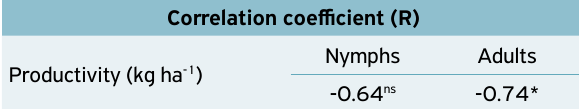
Table 2. Correlation coefficient (R) between root productivity (kg ha-1) and population of nymphs and adults of Vatiga illudens (Hemiptera: Tingidae), present in cassava cultivars from January 2011 to June 2012, Dourados, Mato Grosso do Sul.